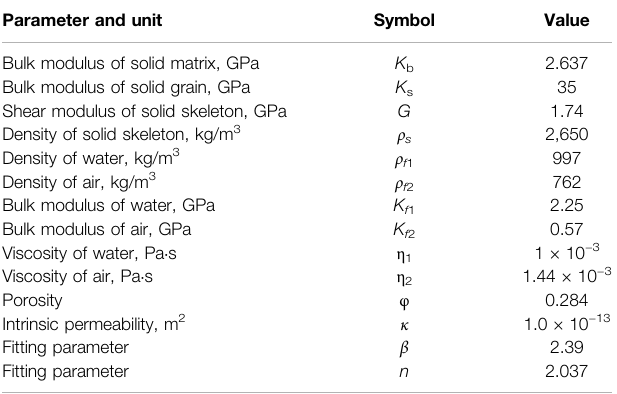
TABLE2| ParametersofColumbialoamcontainingoilandwater(Johnson,2001; Lo et al., 2005). Parameter and unit